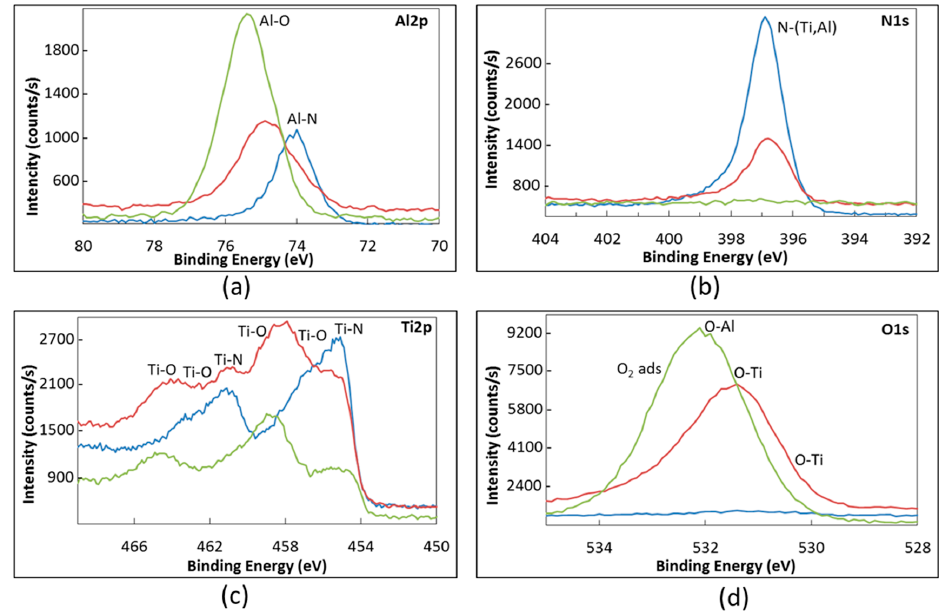
Figure 7. XPS high-resolution spectra of TiAlN1 sample ( a – d ): blue = as processed; red = after 40 burner rig cycles up to 850 °C; and green = after 40 burner rig cycles up to 950 °C.